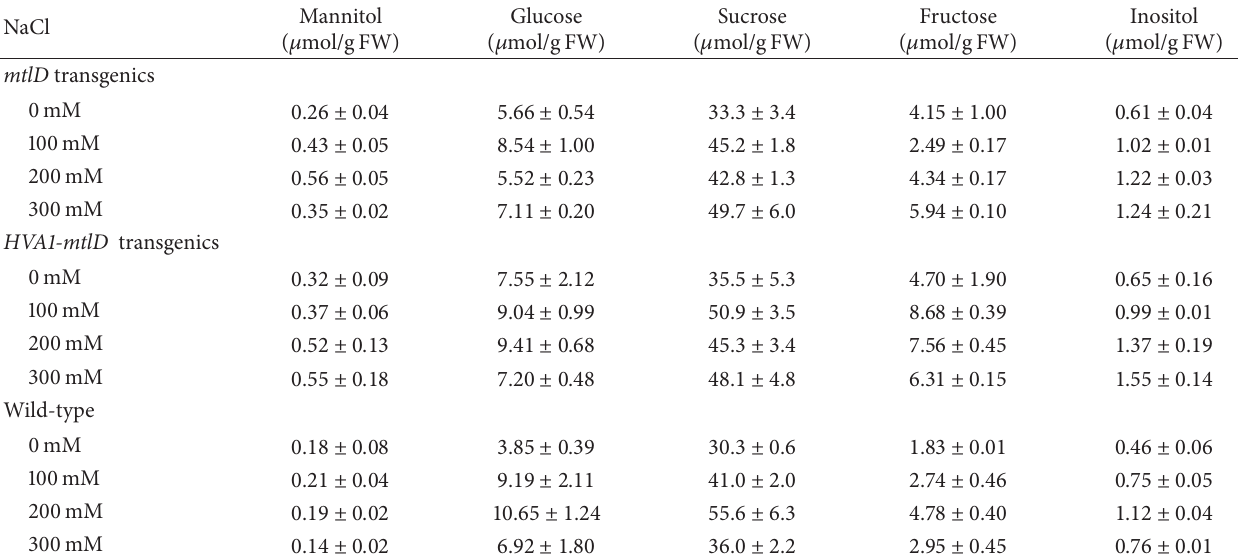
Table 3: Effects of different NaCl concentrations on accumulation of different soluble sugars in T3 versus the wild-type control plants. Mannitol NaCl ( 𝜇 mol/gFW)